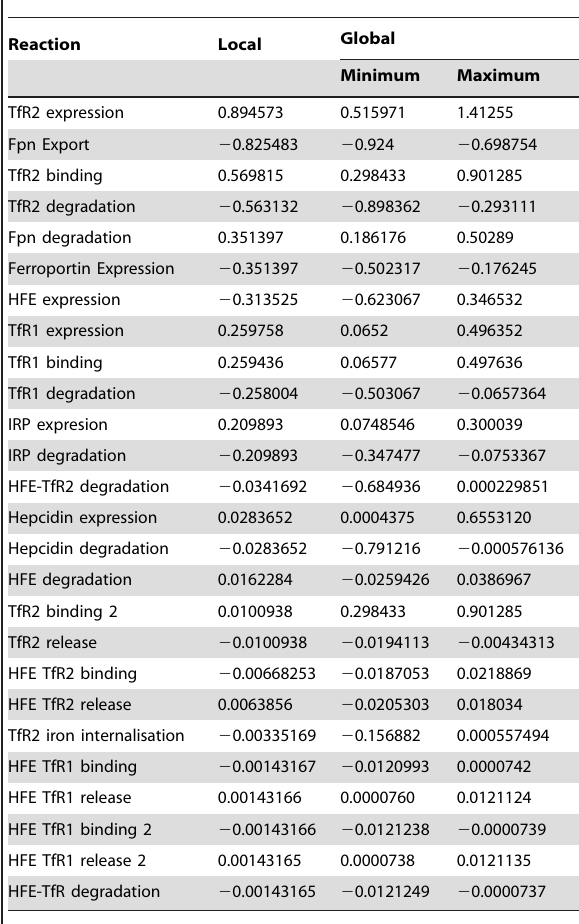
Table 5. Metabolic control analysis—Concentration control coefficients for the labile iron pool.